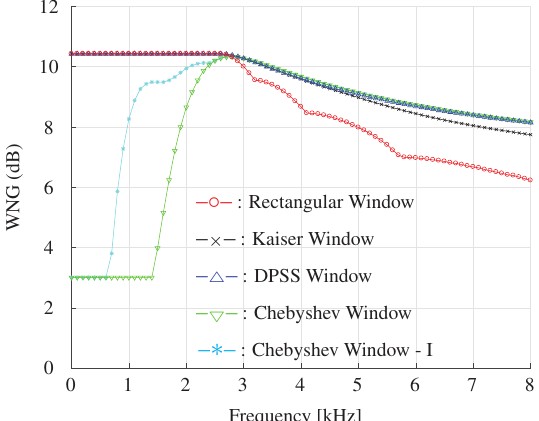
Figure 15. WNG as a function of frequency for different window-based beamformers with a constant beamwidth. The beamwidth is fixed to 40 ◦ , M = 11, δ = 3.5 cm.